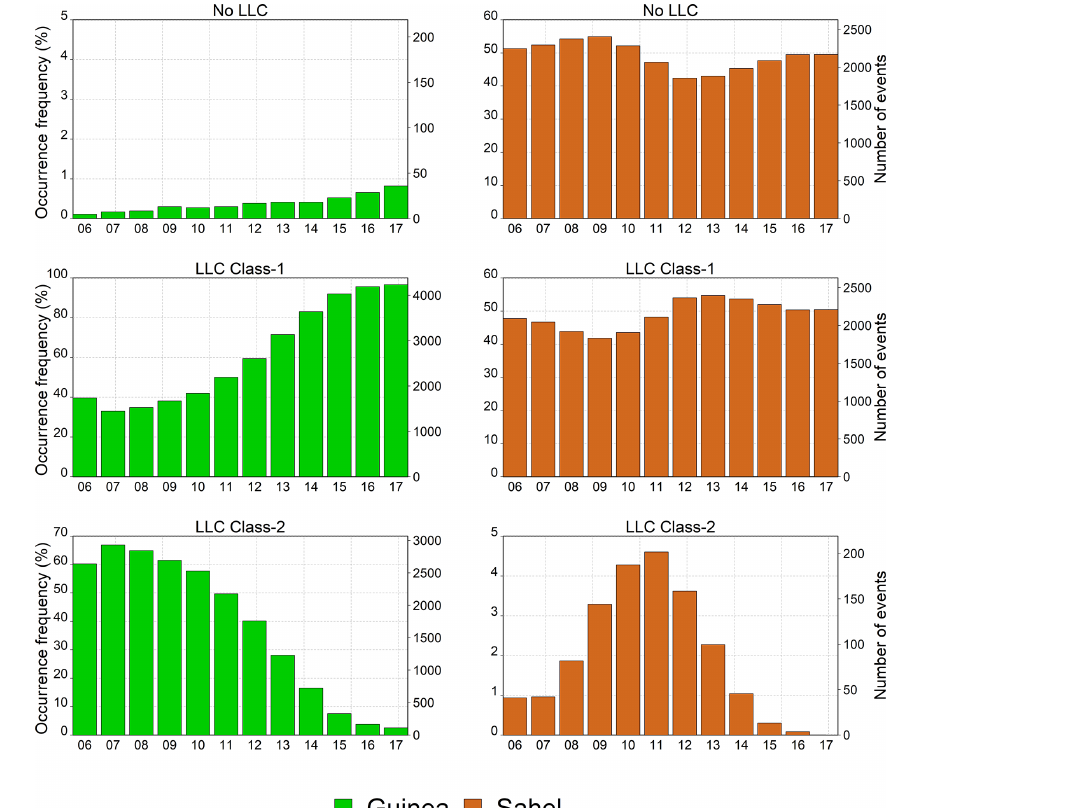
Figure 4. Diurnal distribution of occurrence frequency of the three daytime LLC classes during the daytime in the Guinea and Sahel regions as defined in Fig. 1. All seasons are included in the distribution